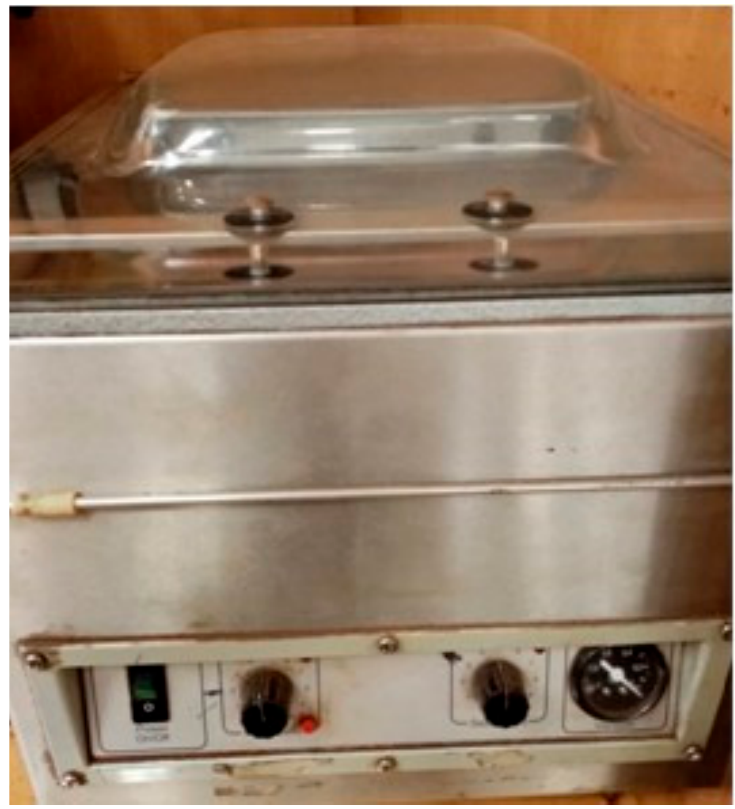
Figure 1. Adopted single-chamber vacuum sealer.